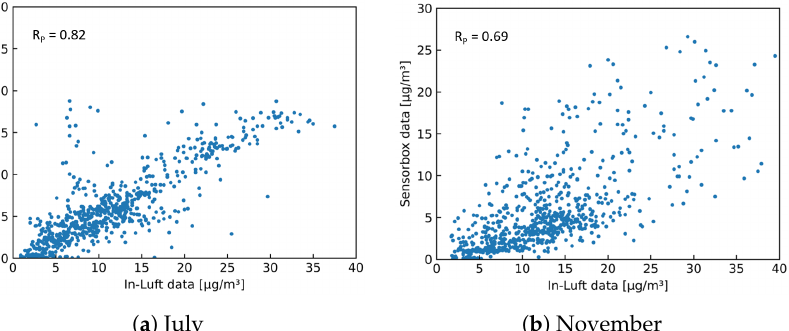
Figure 23. PM 10 hourly mean data recorded with mobile pilot sensor-box 8 located in Cham compared to hourly mean data recorded at the in-luft station located in Zug, Postplatz. ( a ) N = 710, R P = 0.82, R S = 0.81; ( b ) N = 719, R P = 0.69, R S = 0.70.